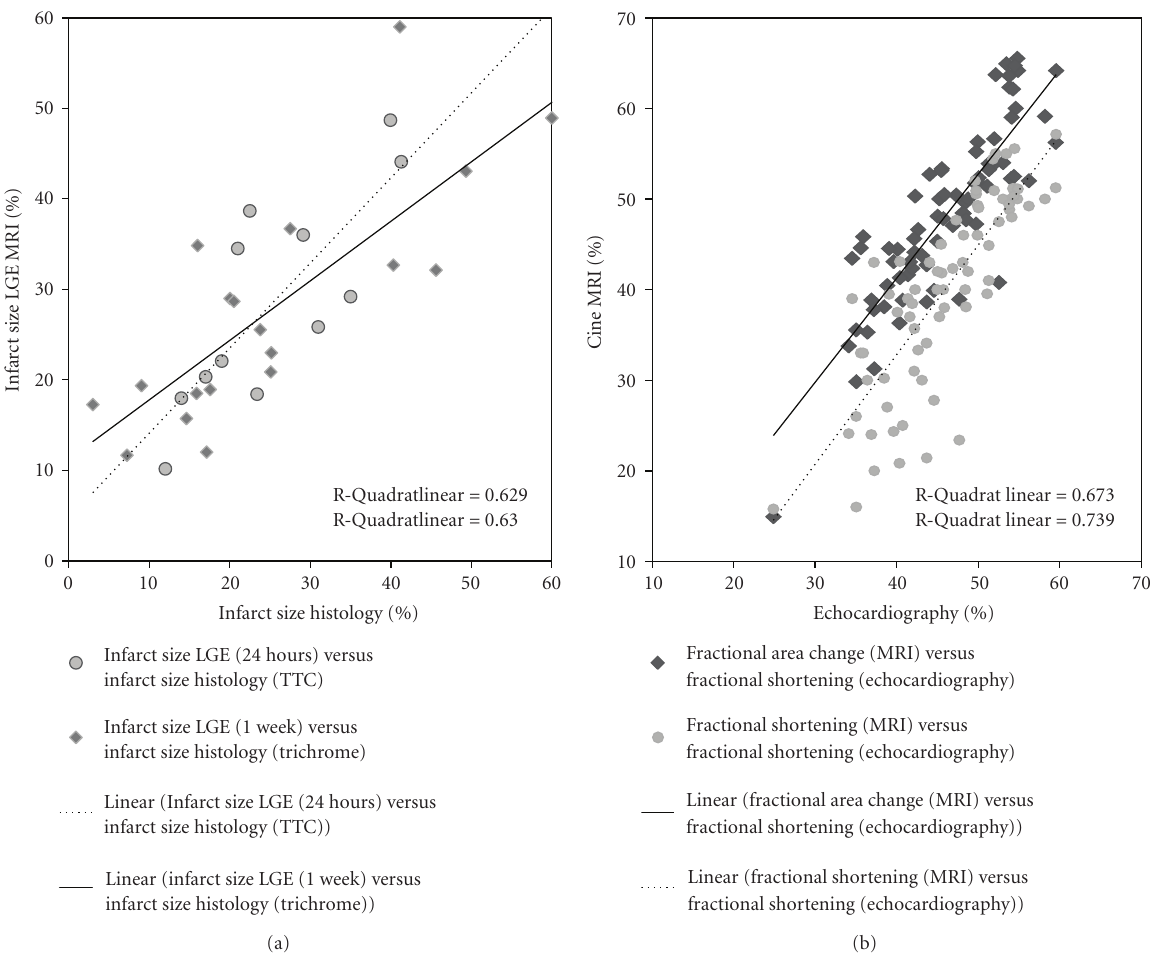
Figure 3: Regression plot showing infarct size and functional parameters. Regression plot of infarct size (a) measured in magnetic resonance imaging with LGE ( Y axis) compared with histological infarct size in TTC staining ( X axis) 24h after procedure (a—circles, broken line). Infarct size determined by magnetic resonance imaging ( Y axis) compared with histological infarct size in trichrome staining ( X axis) 1 week after procedure (a—rhombi, continuous line). Regression plot of functional parameters (b): fractional area change (FAC) (b—rhombi, continuous line) and fractional shortening (FS) (b—circles, broken line) measured in cine magnetic resonance imaging ( Y axis) compared with fractional shortening (FS) measured with echocardiography ( X